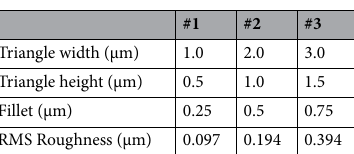
Table 3. Geometry dimensions and RMS roughness of cathode